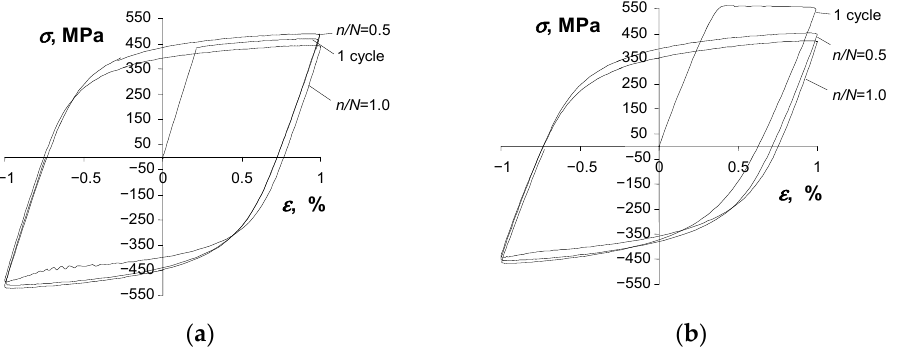
Figure 11. Hysteresis loops at 𝜀 𝑎𝑐 = 0.35%: ( a ) as-received specimen, ( b ) pre-strained specimen.